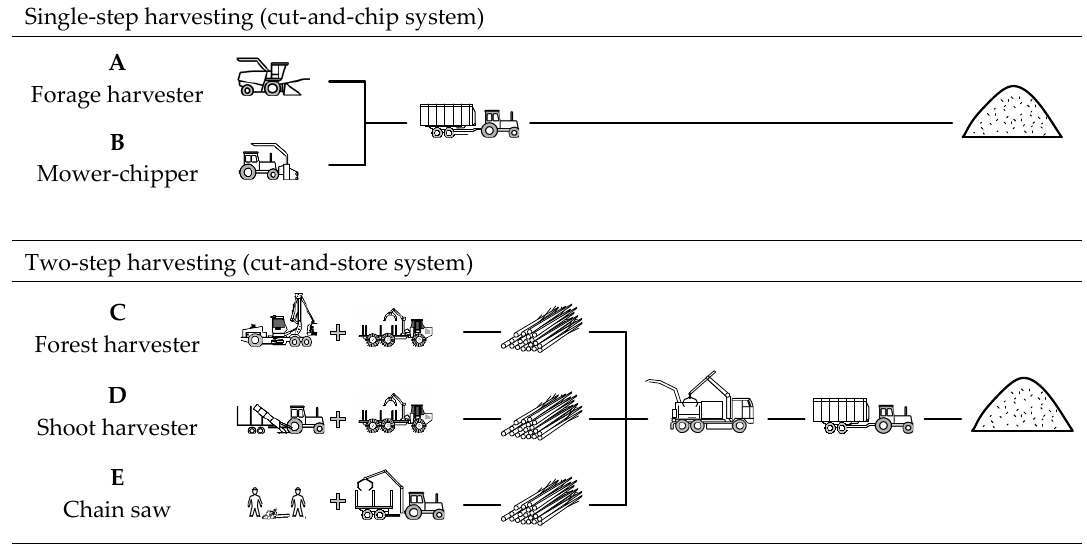
Figure 1. Single-step (A–B) and two-step (C–E) harvesting lines of agricultural wood and processing to wood chips.